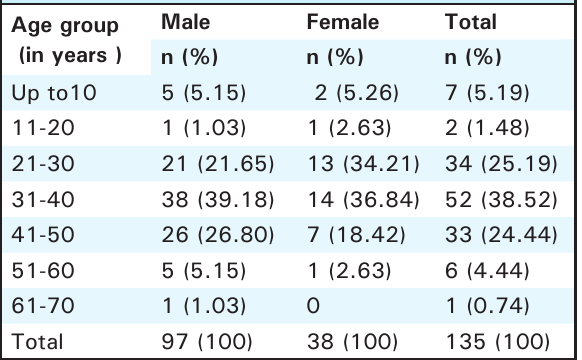
Table 1. Distribution of Subjects by Age and Gender.